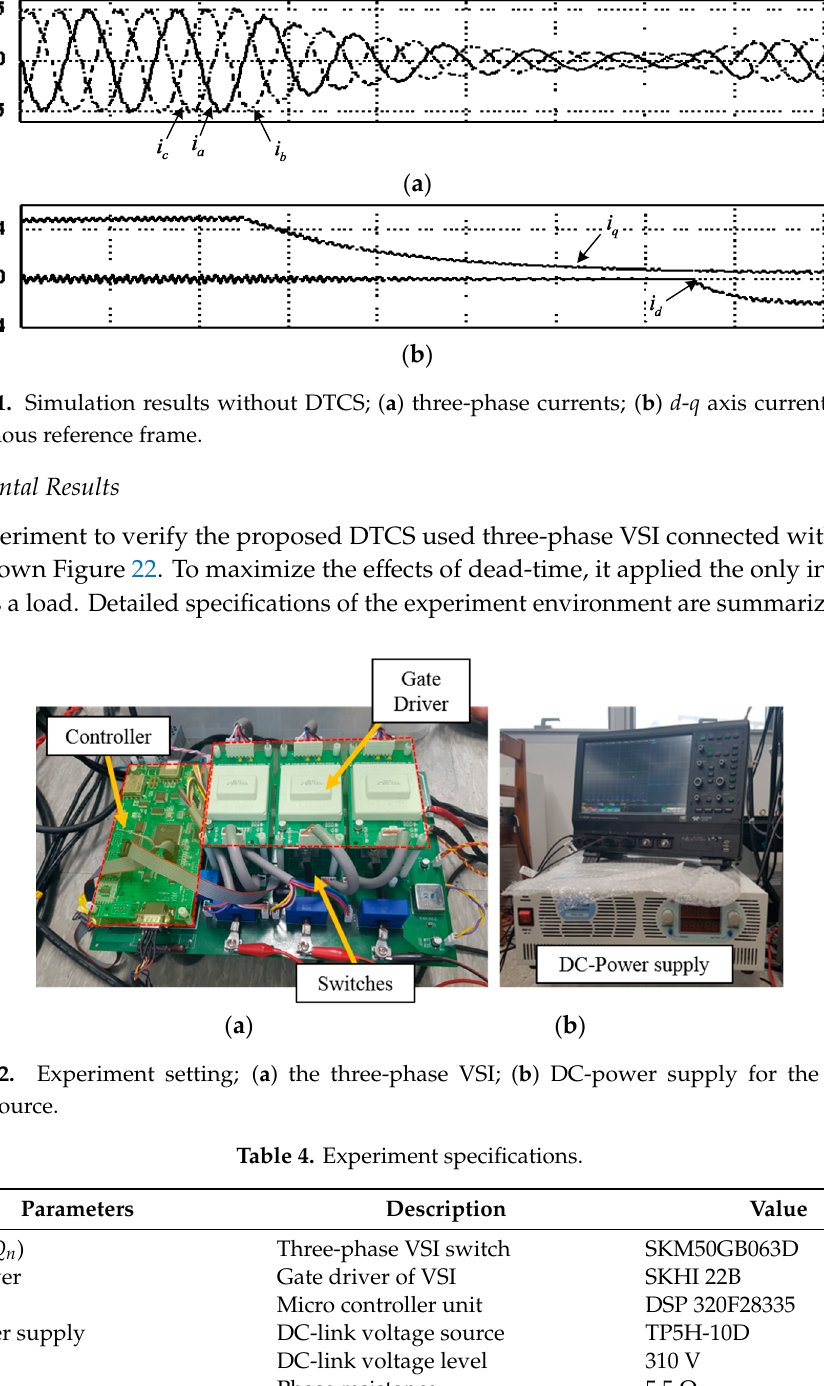
Figure 21. Simulation results without DTCS; ( a ) three-phase currents; ( b ) d - q axis currents on the synchronous reference frame.